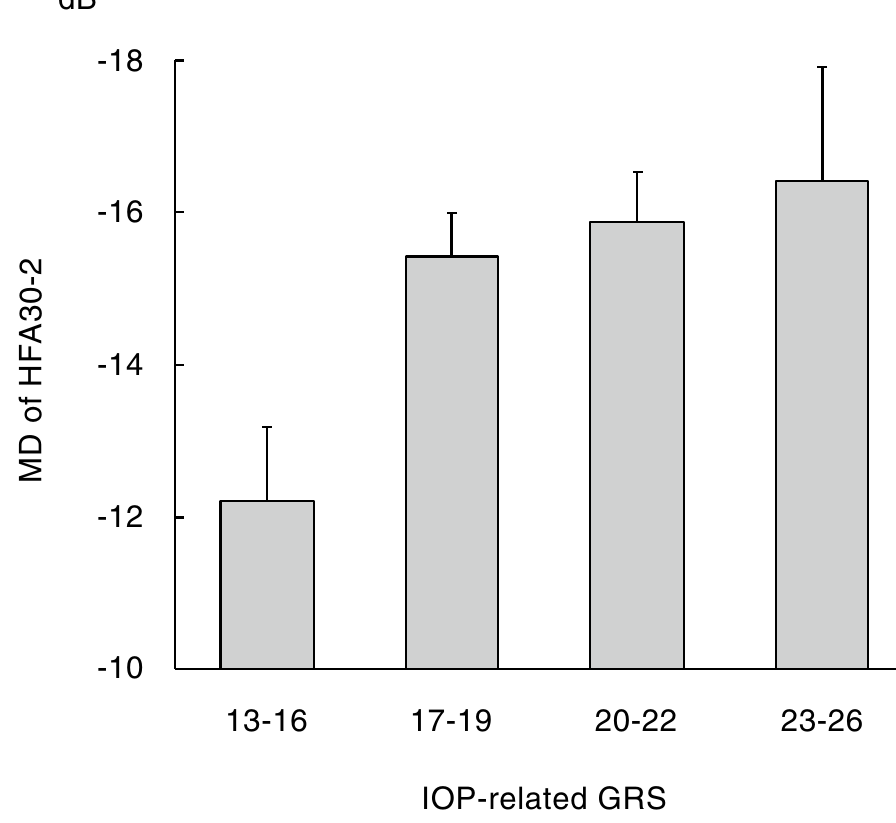
Figure 1. Mean MD values of automated static perimetry (HFA30-2) in the worse eye divided by the GRS of IOP-related genetic variants in patients with primary open-angle glaucoma. As the GRS of IOP-related genetic